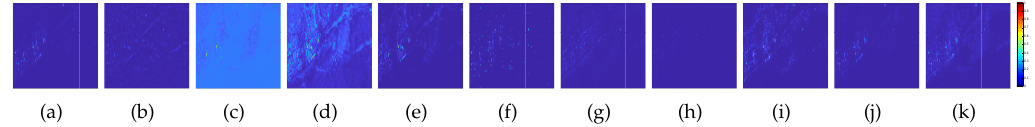
Figure 21. Two-dimensional plots of the detection results obtained by different methods for the Target Detection Blind Test dataset. ( a ) GRX; ( b ) BJSRD; ( c ) LSAD; ( d ) LRASR; ( e ) LSMAD; ( f ) CBAD; ( g ) CRD; ( h ) LRX; ( i ) LKRX; ( j ) OSP; and ( k ) BDSLRR.